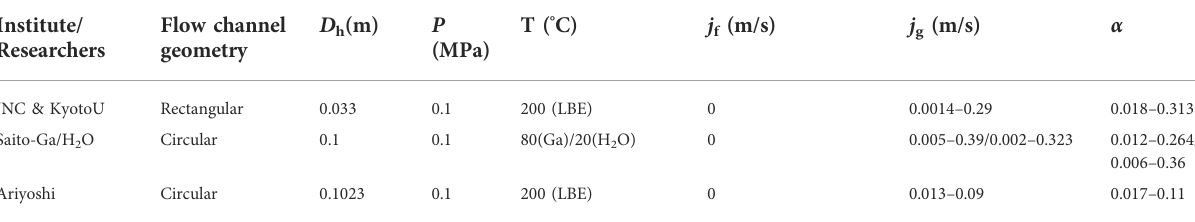
TABLE 2 Experiment study of liquid metal two-phase fl ow.